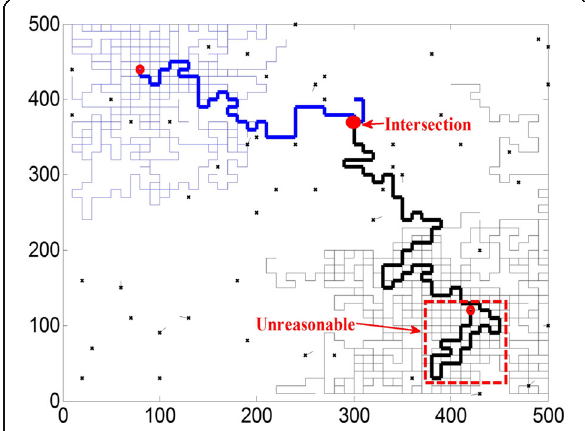
Fig. 3 The diagram of self-avoiding random walk with intersection, where red cycle nodes represent the two bases, the blue and black paths denote the routes walked by walkers from the two bases, respectively. The roundabout path inside the dashed box is unreasonable